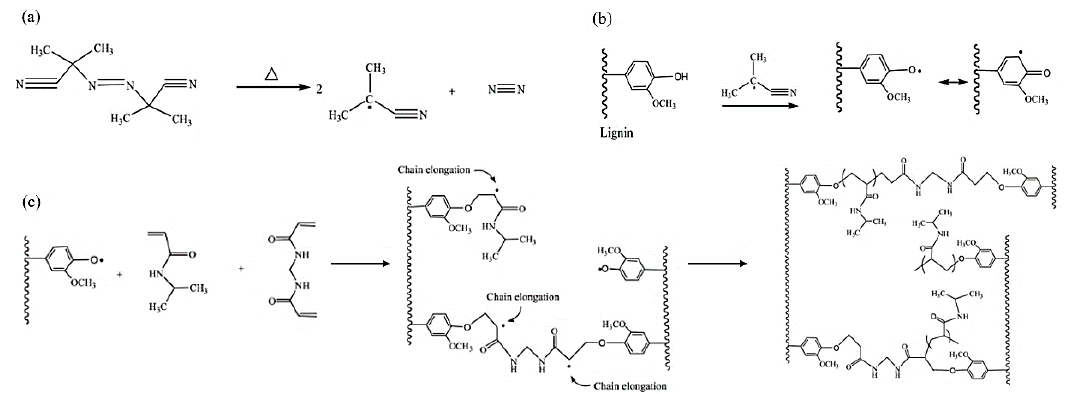
Figure 12. Radical polymerization reaction for lignin-based hydrogel production: ( a ) decomposition of Azobisisobutyronitrile (AIBN) initiator, ( b ) formation of phenoxy radicals, and ( c ) cross-linking reaction [99].